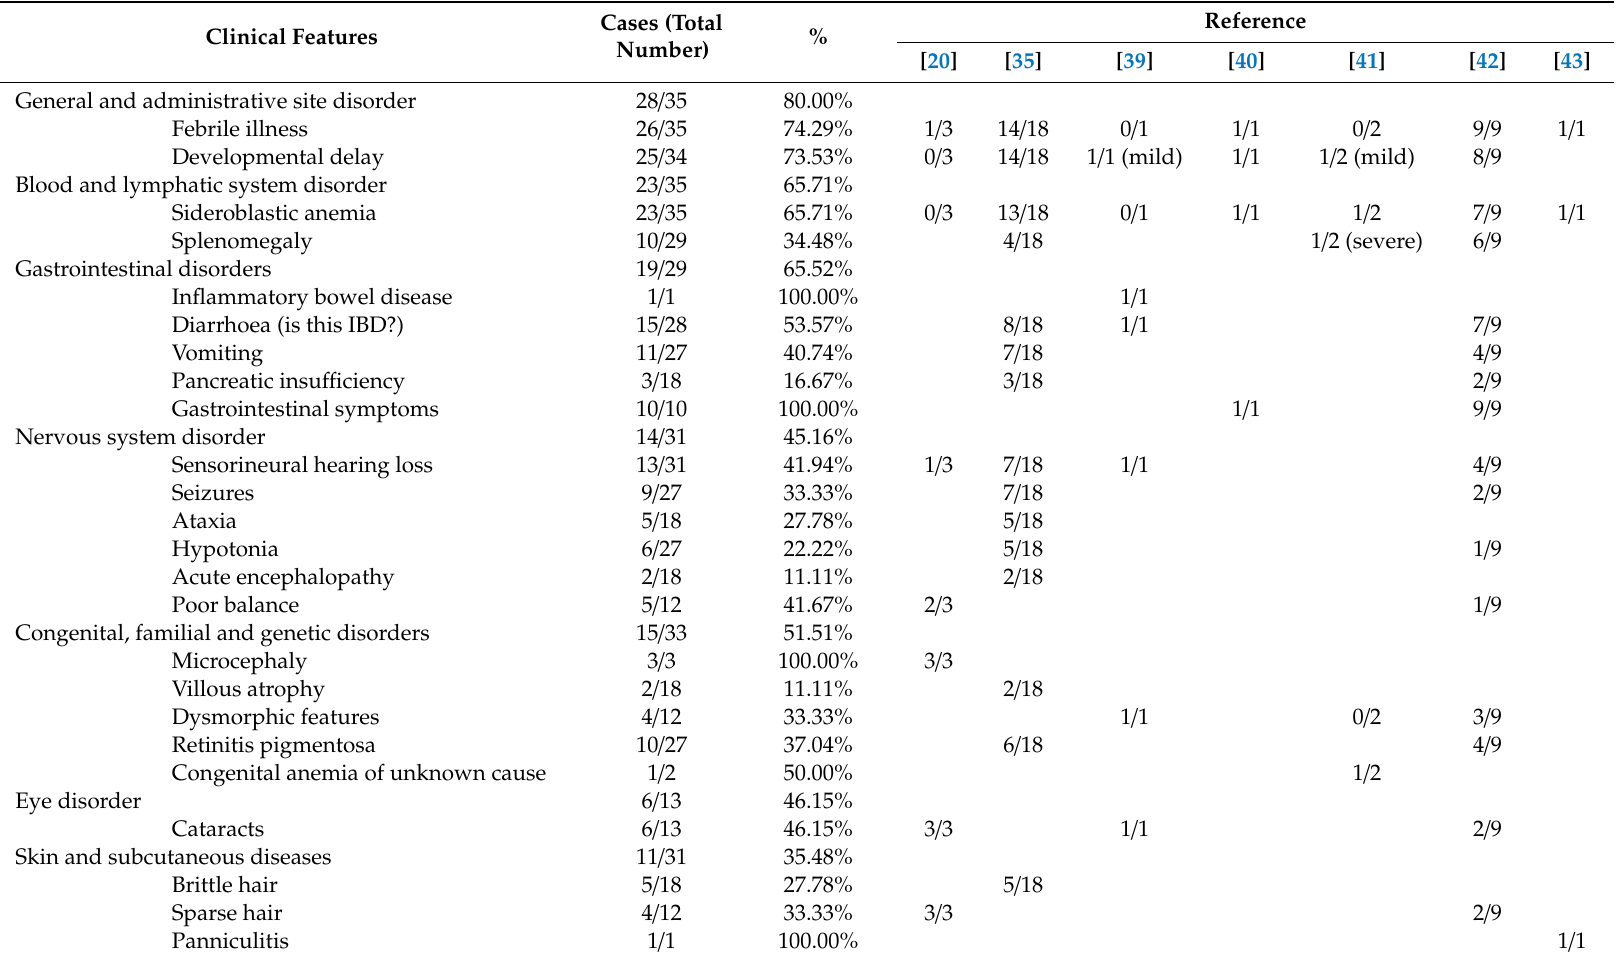
Table 1. Reported clinical and laboratory features and their frequencies associated with TRNT1